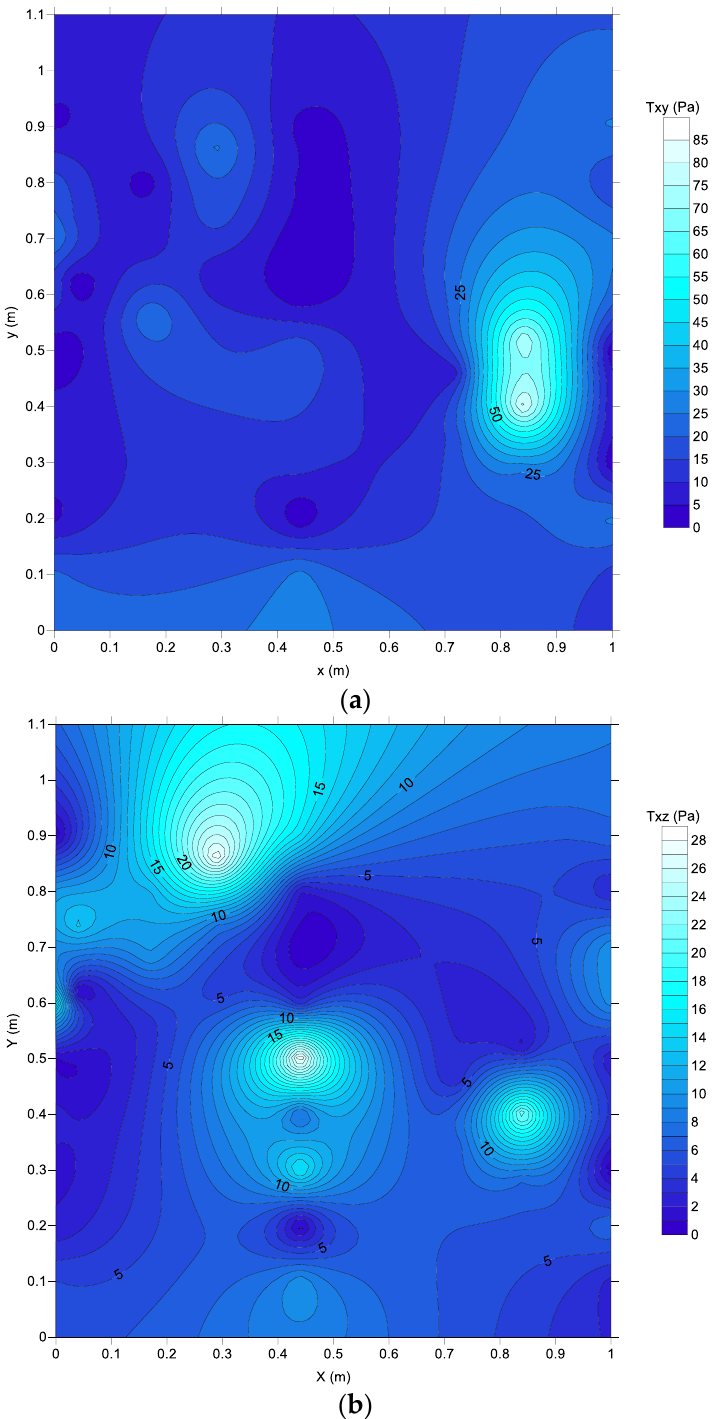
Figure 11. Distribution of the Reynolds shear stresses in the horizontal plane in the representative basin at z/d = 0.60 for Q = 0.187 m 3 /s: ( a ) τ xy and ( b ) τ xz .